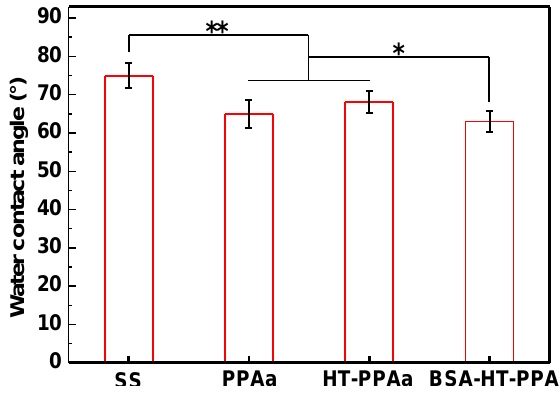
Figure 9. The water contact angle of SS, PPAa, and HT-PPAa and BSA-HT-PPAa film. Data are presented as mean ± SD ( n = 4) and analyzed using one-way ANOVA (* p < 0.05, ** p < 0.01, and *** p < 0.001).